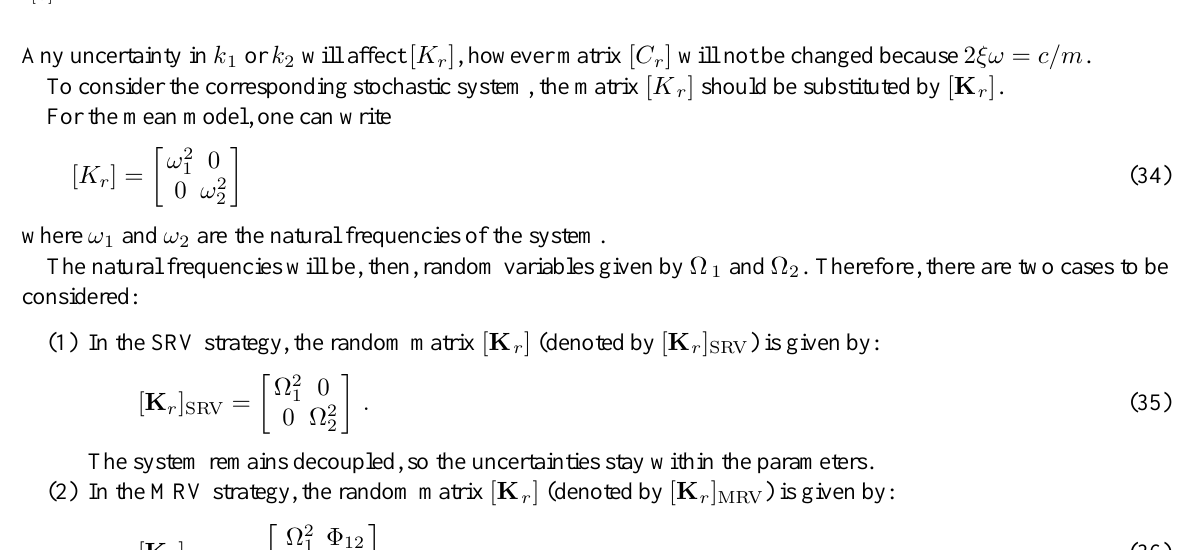
Fig. 5. Results for the FRF of the mean model with 95% confidence limits for both approaches (SRV and MRV). δ K 1 = δ K 2 = 0 . 58 , δ [ = 0 . 65 K ]